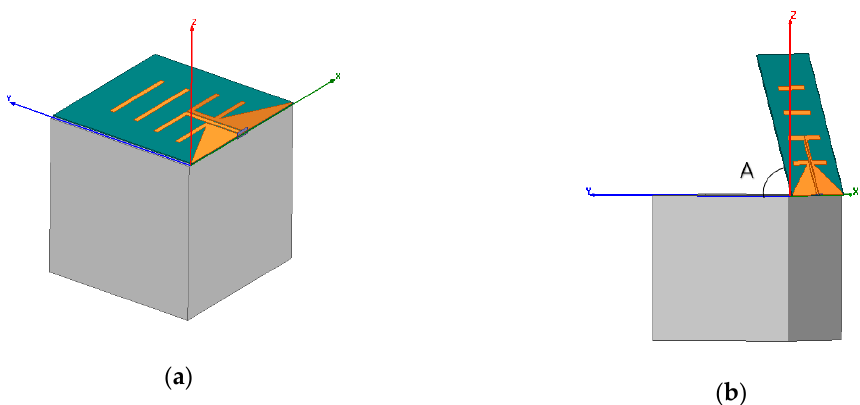
Figure 3. Proposed antenna on CubeSat in: ( a ) Stowed structure and ( b ) Functional structure.